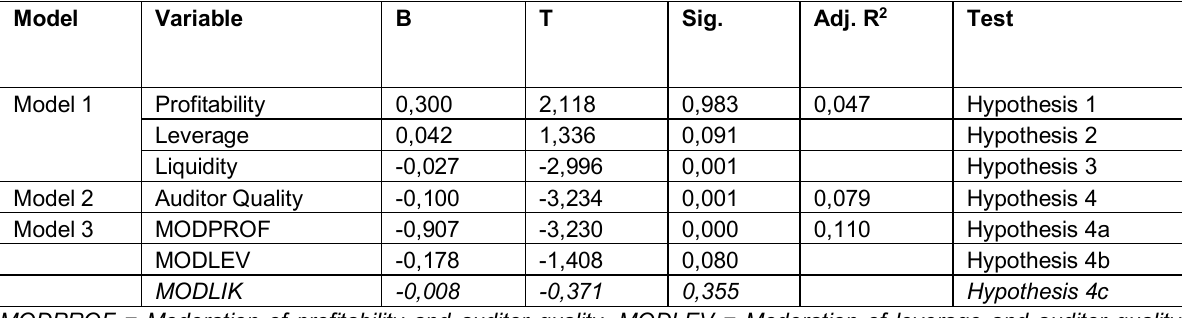
Table 2: Results of Regression